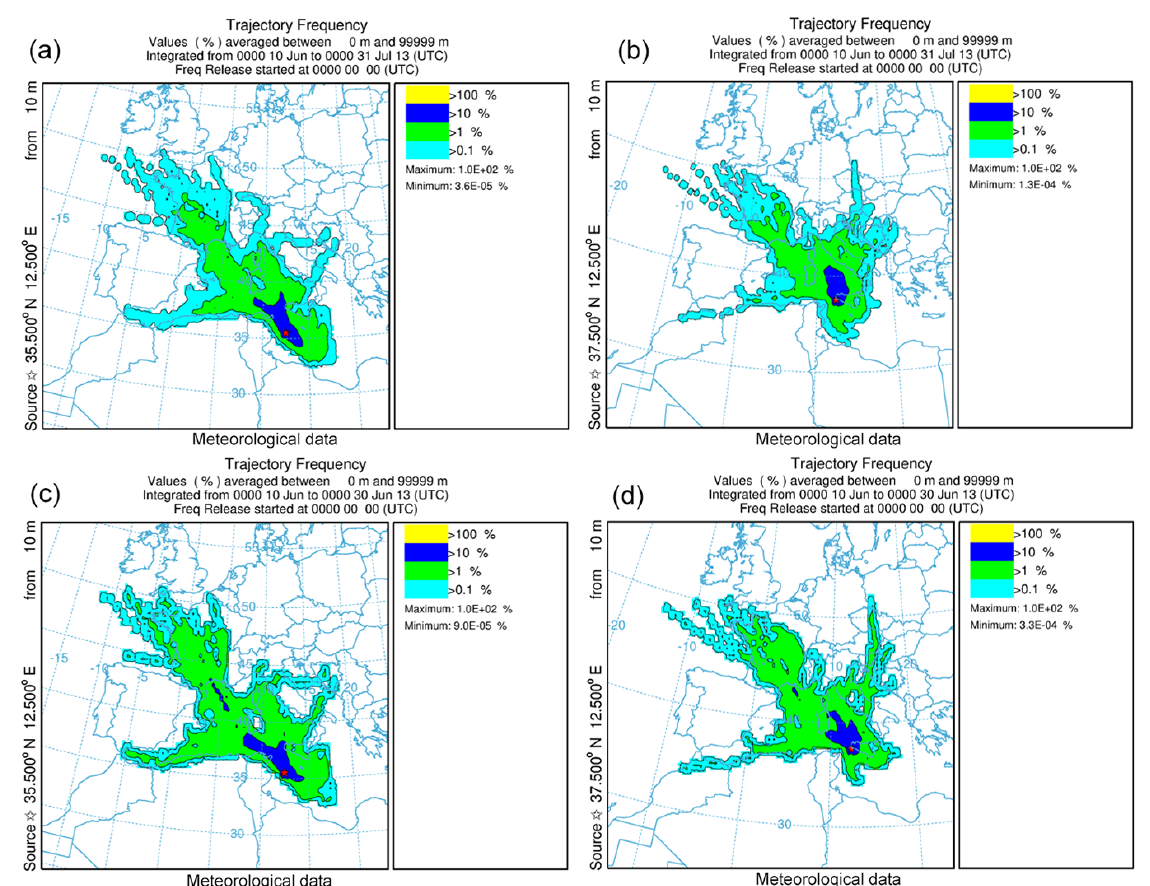
Figure 6. Trajectory frequency computed at each grid cell with starting points at LMP (a, c) and CGR (b, d) . Upper panels show values averaged over the whole period of the campaign (10 June–31 July 2013), while lower panels are relative to the 10–30 June